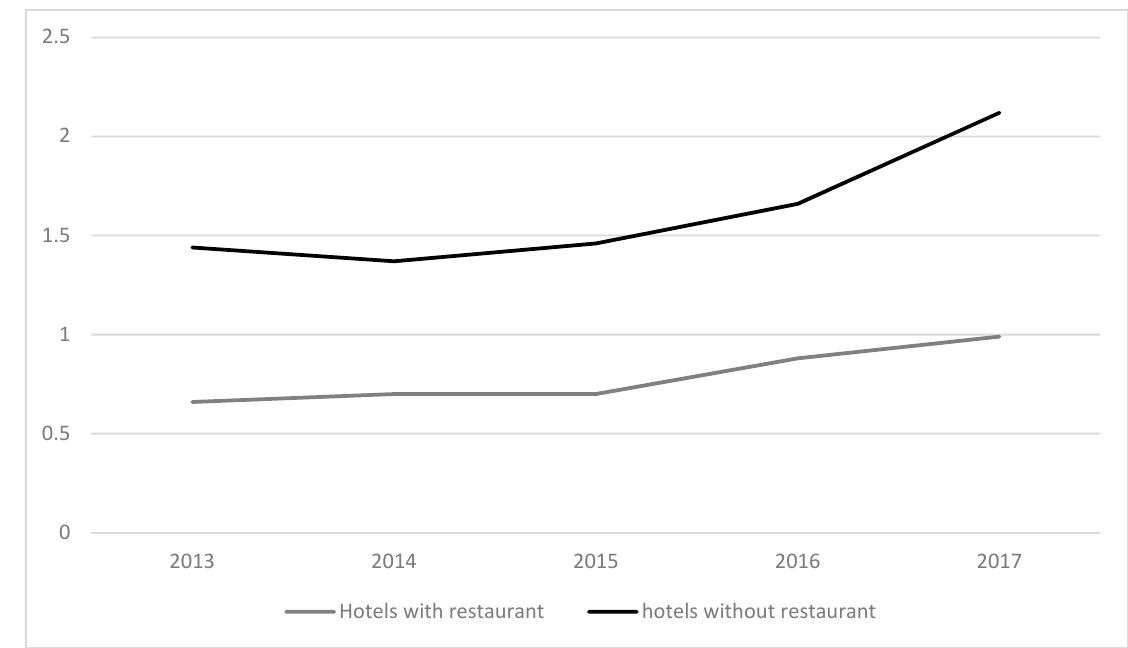
Figure 5 . Current Ratio, with and without a restaurant. Figure 5. Current Ratio, with and without a